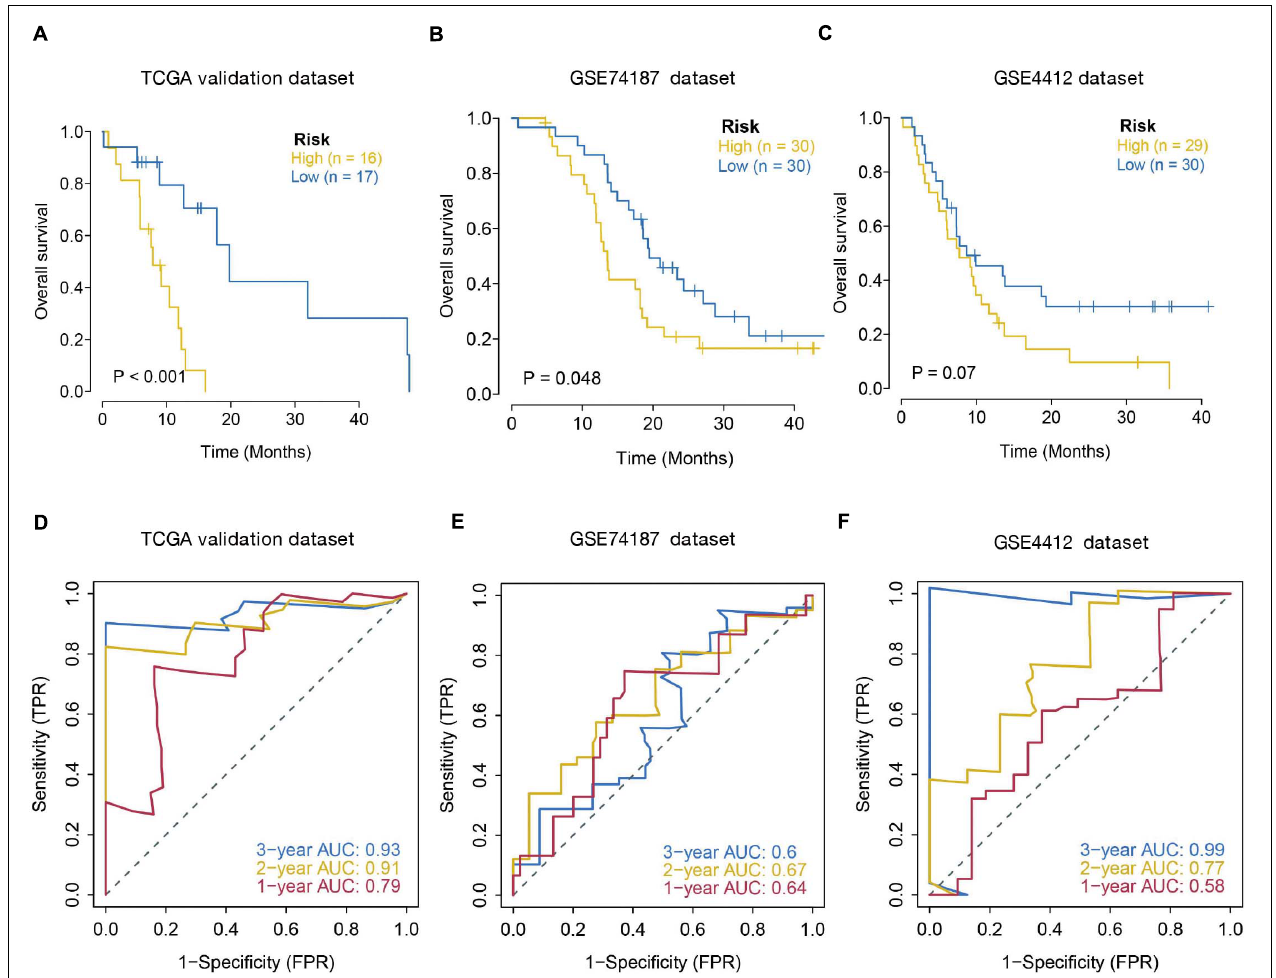
FIGURE 4 | Validation of seven-immune-related gene signature prognostic risk model of GBM patients in validation datasets. (A) Kaplan–Meier survival curves for high-risk and low-risk groups in TCGA internal validation dataset ( p < 0.001). (B) Kaplan–Meier survival curves for high-risk and low-risk groups in GSE74187 dataset ( p = 0.048). (C) Kaplan–Meier survival curves for high-risk and low-risk groups in GSE4412 dataset ( p = 0.07). (D–F) ROC curves to examine the predictive accuracy of the model for OS at 1-, 2-, and 3- years in validation